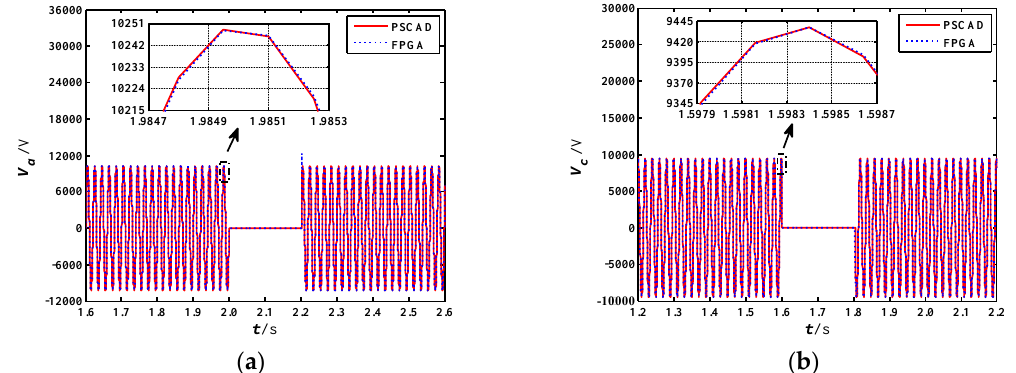
Figure 8. Comparison of the simulation results between the FPGA-based real-time simulator and PSCAD / EMTDC. ( a ) A phase voltage V a of node 22 in Scenario 1. ( b ) C phase voltage V c of node 18 in Scenario 2.